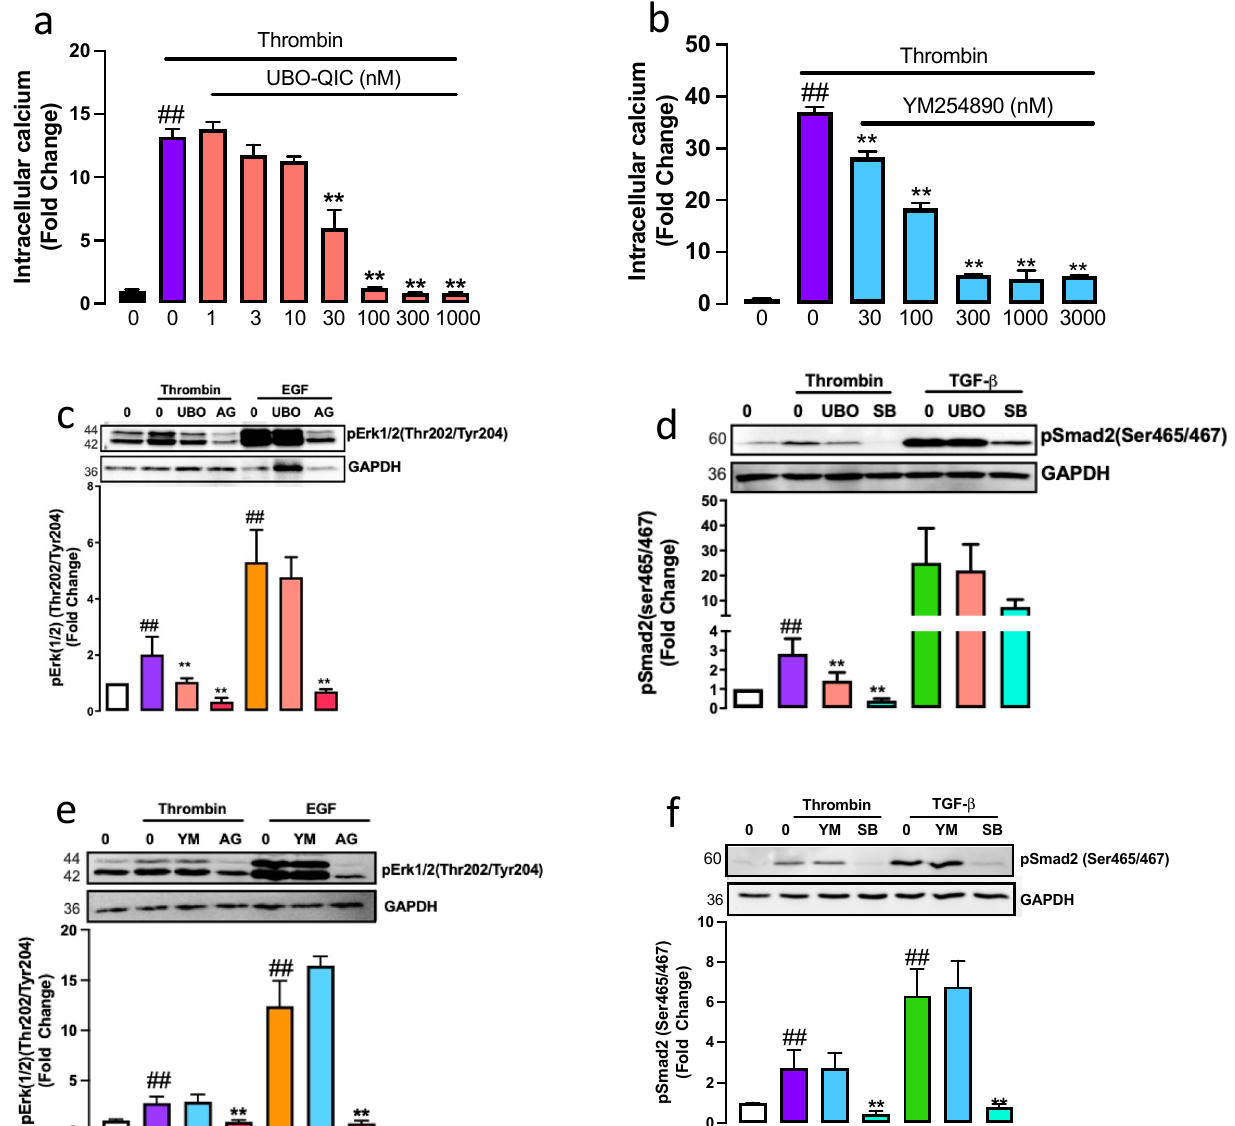
Figure 1. G α q is involved in PAR-1 mediated transactivation of the TGF- β and EGF receptors. To measure the functionality of respective G α q inhibitors, thrombin-mediated intracellular calcium release was assessed using FURA-2AM. Cells were preincubation with ( a ) UBO-QIC (UBO) (1–1000 nM) or ( b ) YM254890 (YM) (3–300 nM) followed by Thrombin treatment. Histograms represent fluorescence intensity compared to the basal level. Cells were pre-incubated with ( c , e ) UBO-QIC or ( d , f ) YM254890 (1 μ M) in the presence of thrombin for ( c , d ) 15 min or ( d , e ) 240 min. ( c , d ) EGF for 5 min or ( d , e ) TGF- β 10 mins in the presence and absence of respective receptor antagonists AG1478 (AG) or SB431542 (SB). Membranes were incubated with ( c , d ) anti-phospho-Erk1/2(Thr202/Tyr204) or ( e , f ) anti-phospho-Smad2(Ser465/467). Histograms represent band density expressed as fold per basal. Statistical significance represents ## basal versus agonist p < 0.01 and ** agonist versus antagonist p < 0.01.